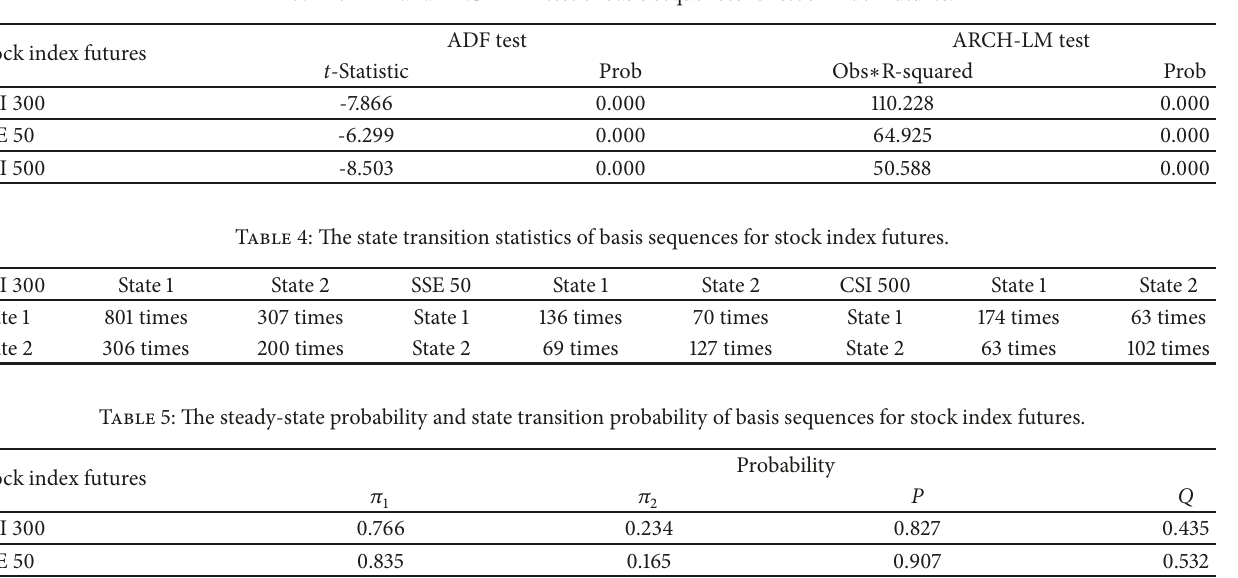
Table 3: The ADF and ARCH-LM test of basis sequences for stock index futures.